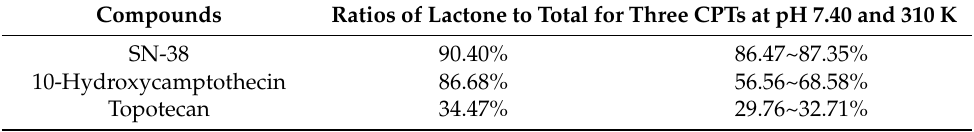
Table 4. The lactone-to-total ratios of 8.0 µ M SN-38, 10-hydroxycamptothecin and topotecan after addtion of 2.0 µ M IVIG within the subsequent incubated 60 min, at pH 7.40 and 310 K, respectively